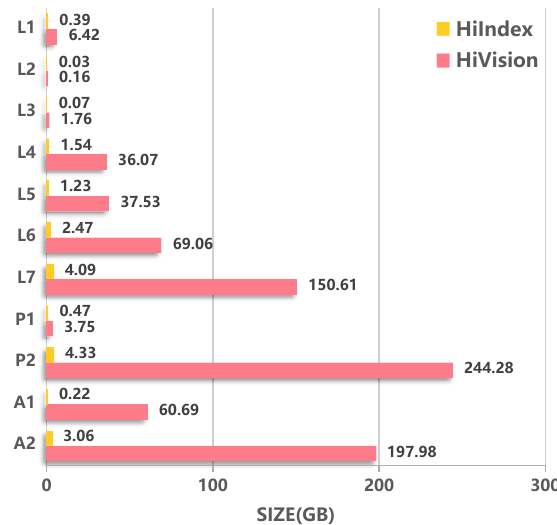
Figure 8. Index occupation in disk storage. To sum up, in terms of data pre-processing for large-scale geographic vector data, HiIndex has a shorter index construction time and smaller memory occupation, which has an excellent